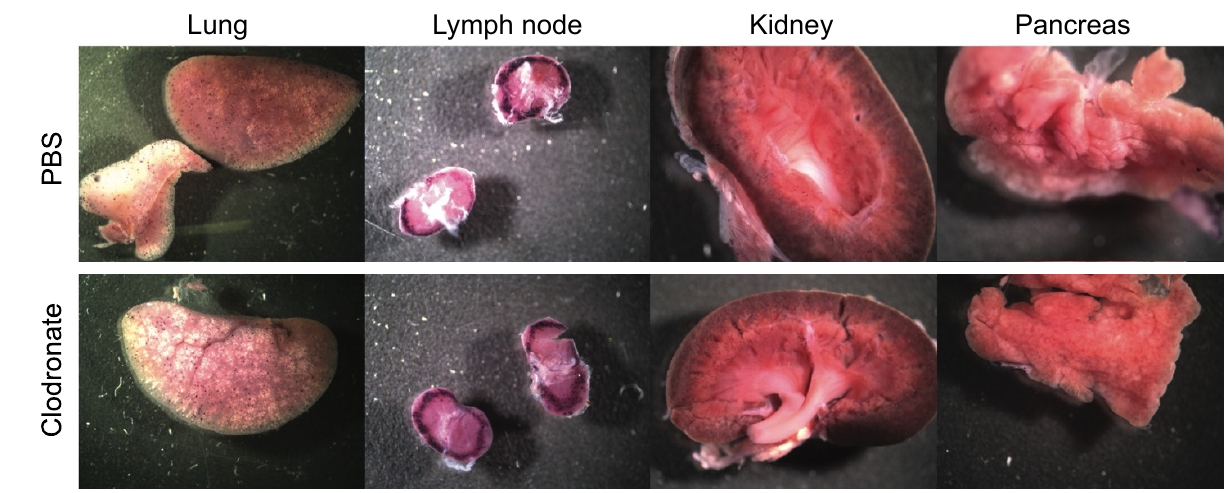
Figure 3. Representative gross images of lung, lymph node, spleen, and kidney from clodronate-treated mice and control mice. Both groups ( n = 4) were administered 1 × 10 11 vg of AAV vector expressing human placental alkaline phosphatase (hPLAP) via tail vein injection and euthanized 28 days later. Tissues were fixed and stained for hPLAP expression. There did not appear to be grossly visible differences between these two groups of mice in these particular organs. Expression of hPLAP in these organs was relatively low.